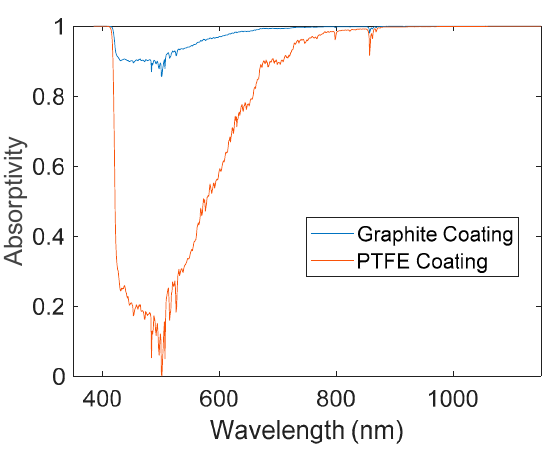
Figure 5. Local absorptivity as a function of wavelength. Table 3. Coe ffi cients of solar absorption for various coating types.